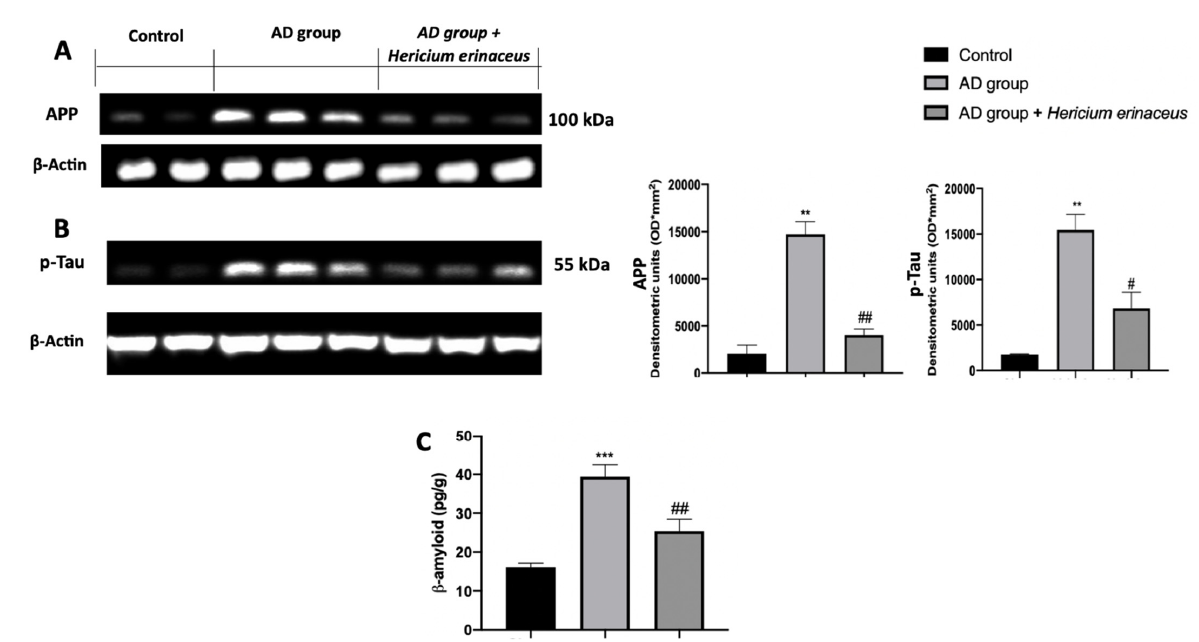
Figure 2. Hericium erinaceus administration decreased AD markers in hippocampus. Western blot analyses of amyloid precursor protein (APP) ( A ) and p-Tau ( B ) expression; β -amyloid levels ( C ). For western blot and ELISA analyses, n = 5 animals from each group and for each analysis were employed. A p -value of less than 0.05 was considered significant. # p < 0.05 vs. vehicle, ** p < 0.01 vs. control, ## p < 0.01 vs. vehicle, *** p < 0.001 vs. control.